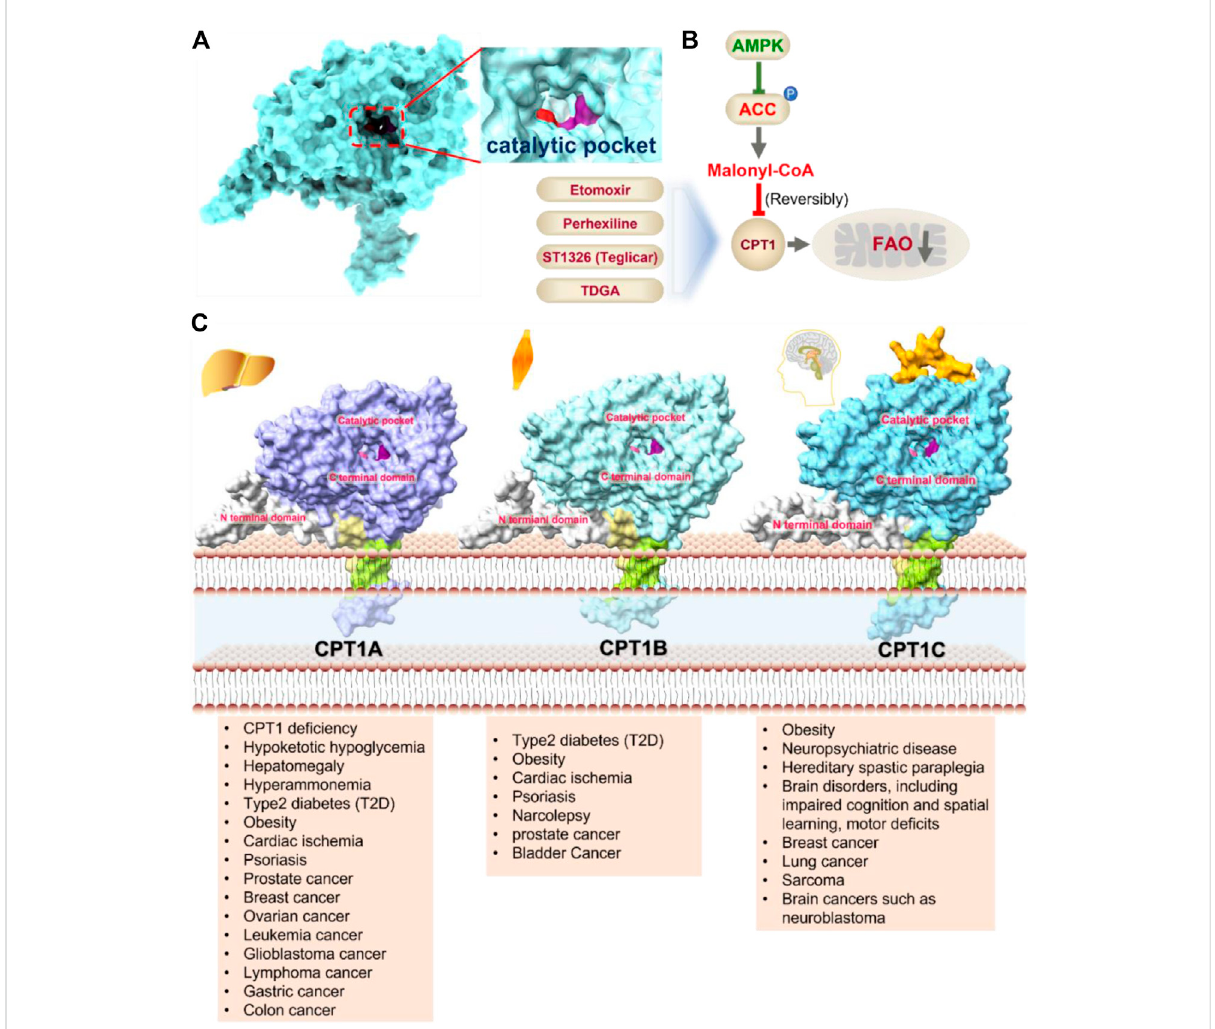
Structure model, notble inhibitors and related disease summary of pharmaceutical target CPT1. (A) Structure model of human CPT1 with catalytic pocket highlighted with a magni fi ed view. (B) Four notble inhibitors (Etomoxir, Perhexipin, ST1326, TDGA) and physiological inhibitor malonyl-CoA can impair FAO via blocking CPT1. Malonyl-CoA level can be regulated by AMPK-ACC axis. (C) Structure model for three isoforms of CPT1 (from AlphaFold database), with related diseases are listed under the respective structure model. The liver isoform — CPT1A, the main isoform involved in FAO; the muscle isoform — CPT1B; the brain isoform — CPT1C with little acyltransferase activity. All three isoforms consist of an N-terminal regulatory domain, a C-terminal catalytic domain, and two transmembrane helices, and the catalytic pocket is highlighted by